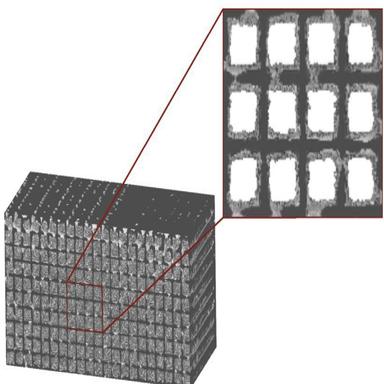
Specimen 600: Voxel model after segmentation.